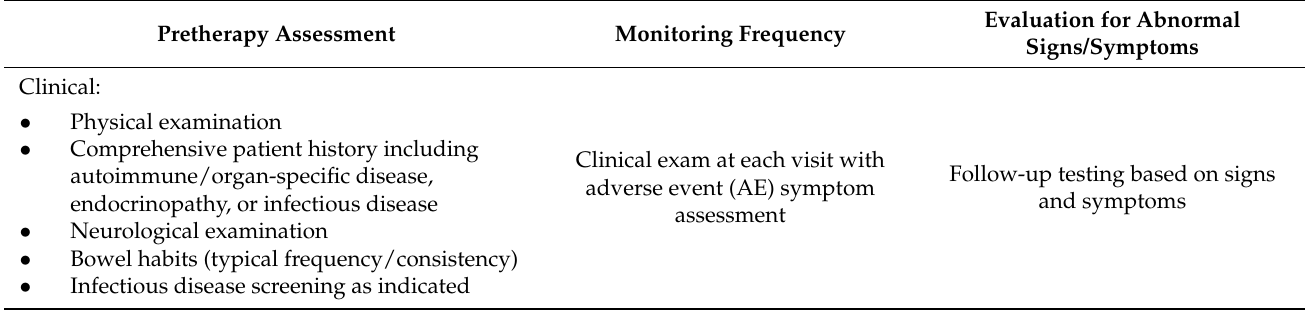
Table 1. Pre-therapy assessment for patients undergoing